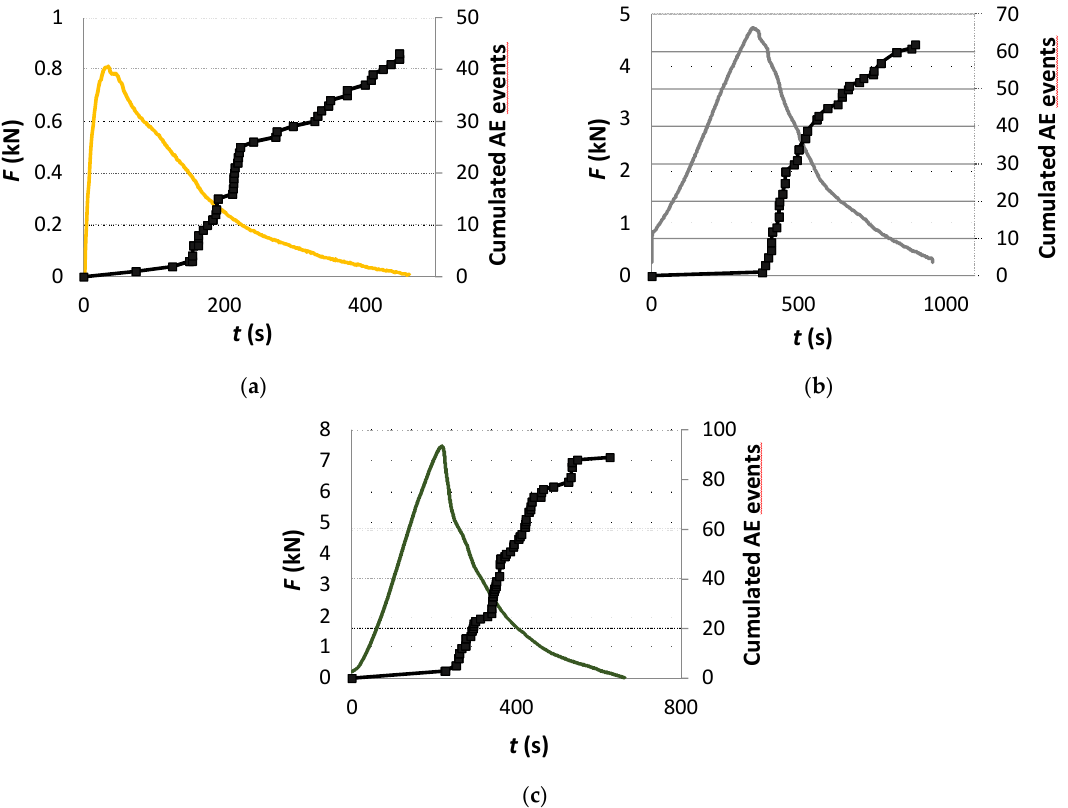
Figure 7. Load and cumulated AE events vs. time for ( a ) d = 100 mm, ( b ) d = 300 mm, ( c ) d = 400 mm.